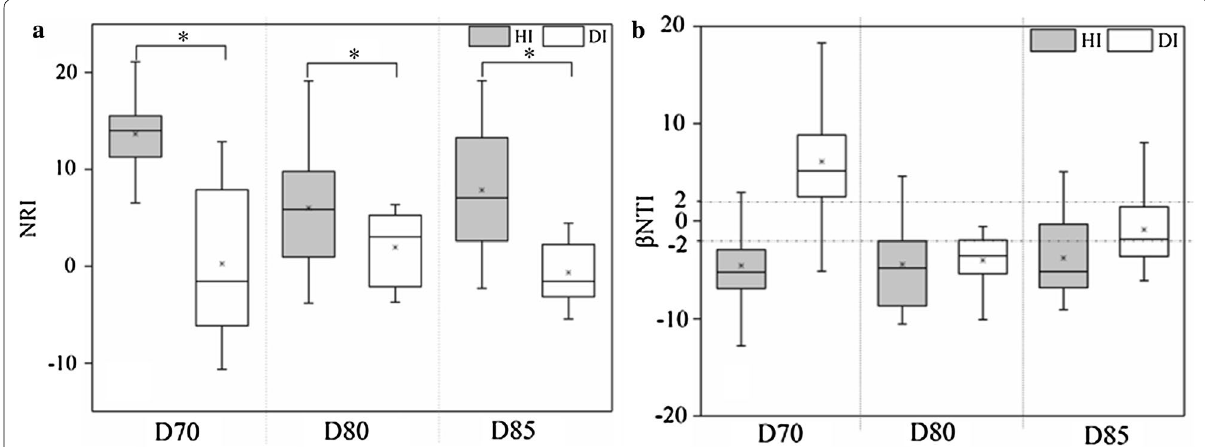
Fig. 1 The net relatedness index (NRI) ( a ) and β-nearest taxon index (βNTI) ( b ) of the shrimp gut samples under different health state across three sampling days. Horizontal dashed lines in b indicate upper and lower significance thresholds at βNTI diseased gut. Significant differences were indicated by the asterisk (* P < 0.05) based on one-way analysis of variance. Lines at the top, bottom, and middle of the box correspond to the 75th, 25th, and 50th percentiles (median), respectively. The asterisk in the box represents the mean